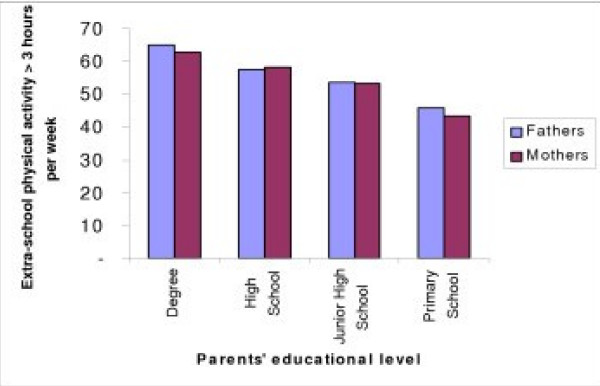
Relation between students' hours of extra-school physical activity and parents' educational level.